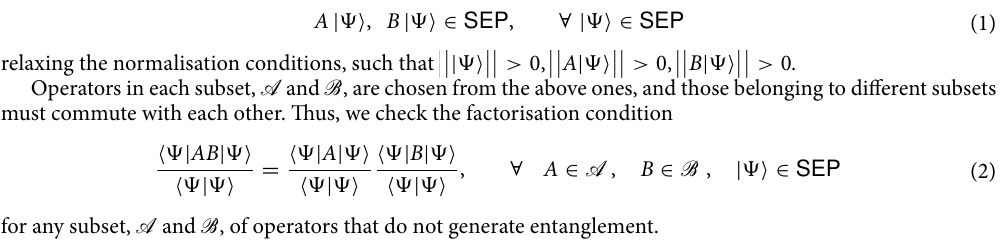
< 1 , and overlap almost completely L R � | �